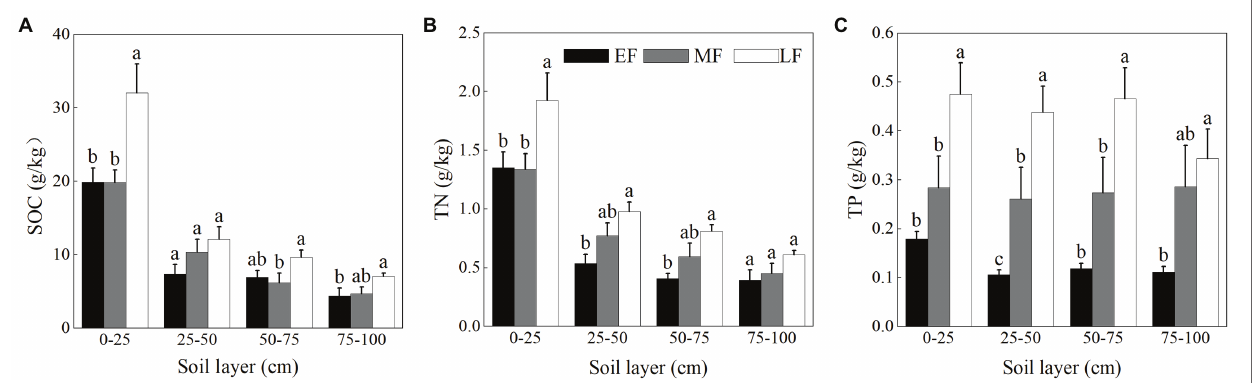
FIGURE 2 | The contents of SOC (A) , TN (B) , and TP (C) in the 0–100 cm soil layer of different forests. Values are the means ± SE ( n = 6). Lowercase letters above the columns represent statistically significant differences among stand types for the same soil layer (Duncan’s tests, p < 0.05). SOC, soil organic carbon; TN, soil total nitrogen; TP, soil total phosphorus; EF, broadleaf–conifer mixed forest; MF, broad-leaved forest; LF, old-growth